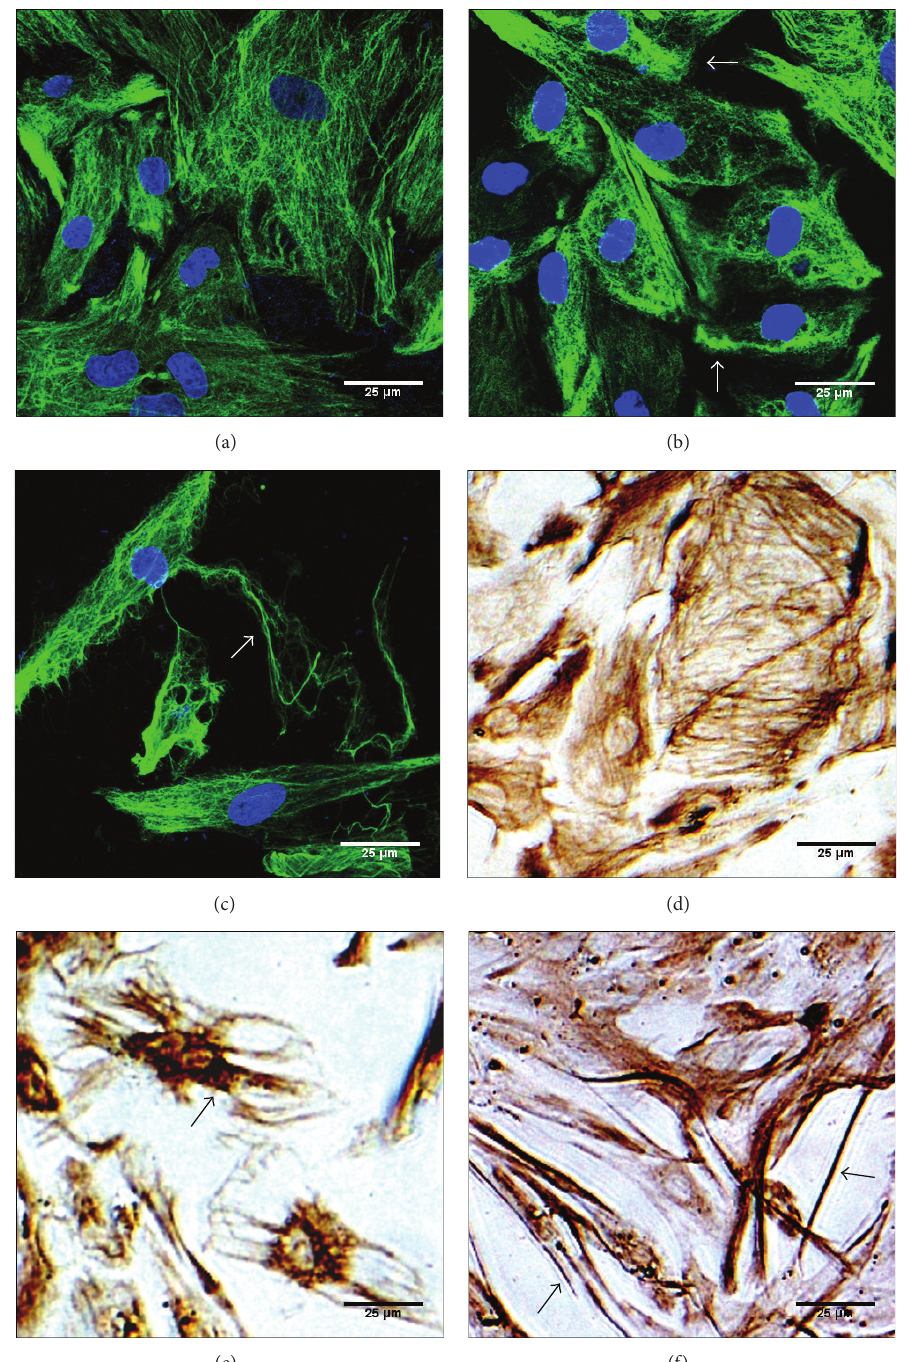
Figure 4: Immunofluorescence and immunocytochemical experiments of vimentin in control and DBP- and SB431542 + DBP-treated SCs at 24 h. (a) and (d) represent the control group; (b) and (e) represent the DBP-treated group; (c) and (f) represent the SB431542 + DBP-treated group (magnification: 200x). The distribution of vimentin showed abnormal aggregation in subregions of SCs (as shown by arrows) compared with the control group. The distribution of vimentin in the SB431542 + DBP-treated group showed many irregular long filamentous